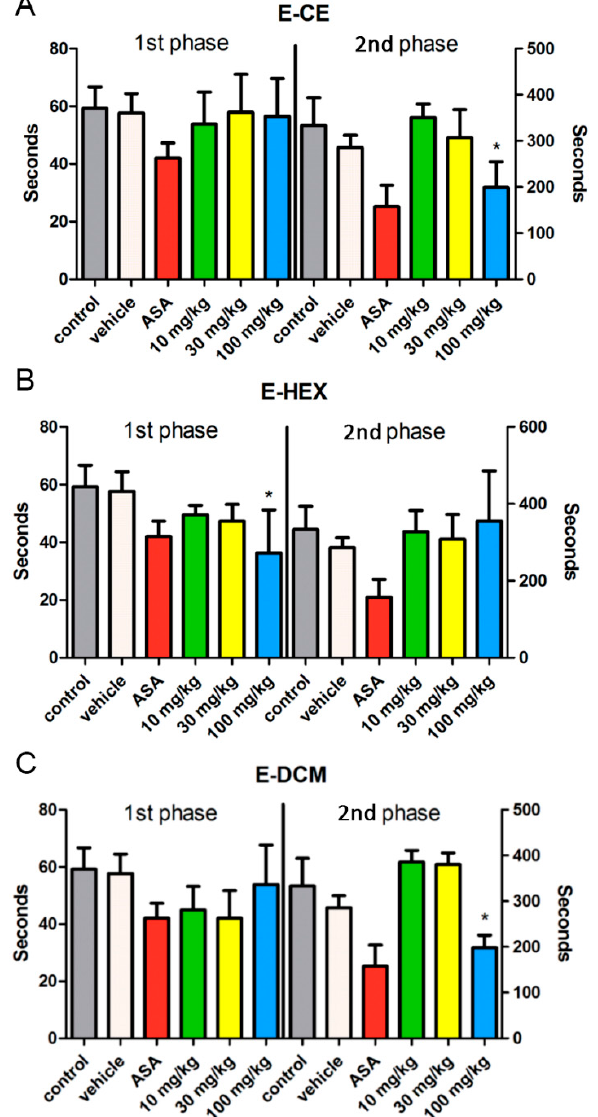
Figure 5. Formalin-induced licking response test for ( A ) crude ethanol extract of Elsholtzia ciliata (E-CE), ( B ) fraction in hexane (E-HEX) or ( C ) fraction in dichloromethane (E-DCM) at different concentrations (10, 30 and 100 mg/kg). Animals were pre-treated with an oral dose of acetylsalicylic acid (ASA, 100 mg/kg) or vehicle. The results were presented as mean ± SD (n = 6). Statistical significance between groups (*) was calculated by analyses of variance (ANOVA), followed by Bonferroni’s test. p values less than 0.05 ( p ≤ 0.05) were used as the significant